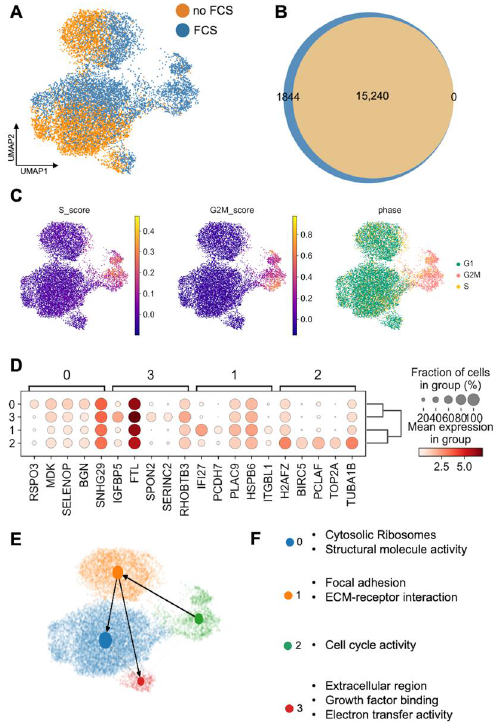
Figure A2. ( A ): UMAP plot of samples derived from HTPC-2 with and without FCS. ( B ): Venn diagram indicates overlap of both samples. The exposure of HTPCs to FCS results in the expression of 1844 additional genes. ( C ): Cell cycle stages [31] display one distinct proliferating cluster in the FCS sample. ( D–F ): Four distinct states of cellular differentiation were observed, indicating plasticity and proliferation. ( D ) Dot plot demonstrates expression of most abundant genes in each cluster. ( E ) Velocity analysis was embedded into the PAGA graph, which indicates trajectory of the proliferating cluster into cluster 1 and the two other functional subgroups. ( F ) Representative GO-terms after string analysis with upregulated genes.